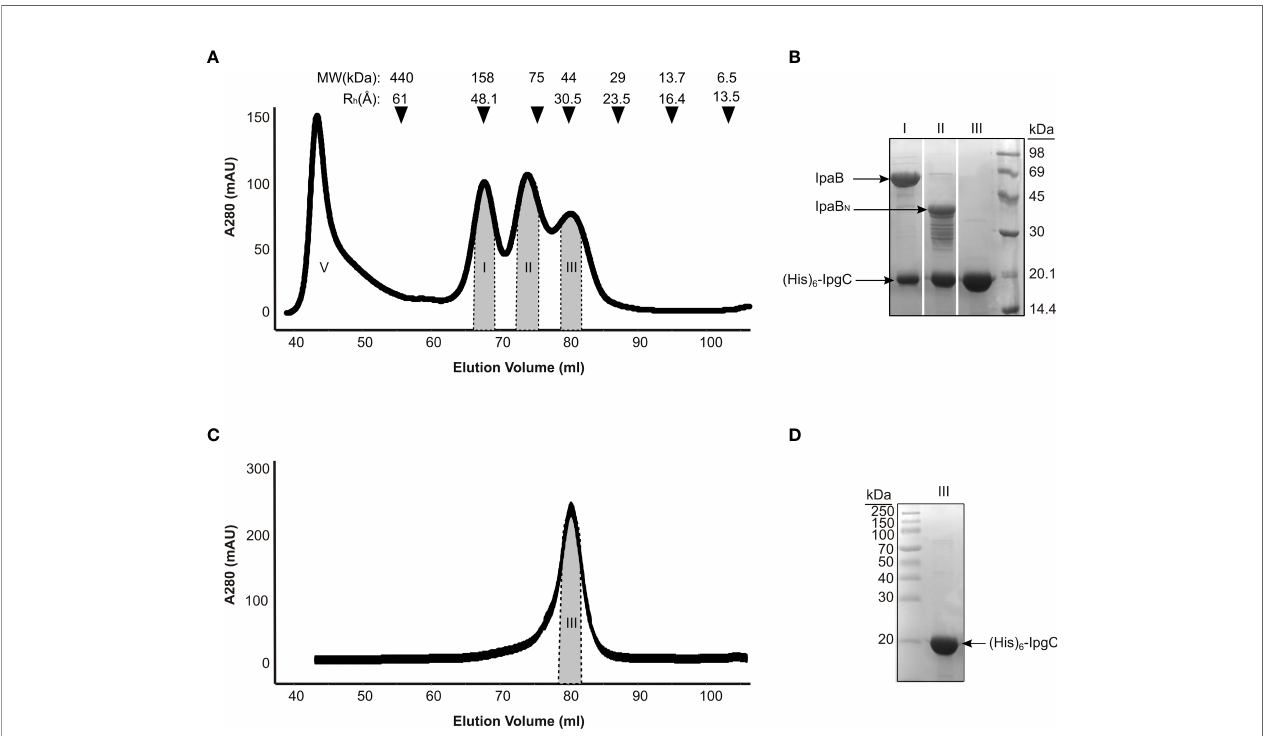
FIGURE 2 | IpgC/IpaB available structural information and hydrodynamic parameters. (A) Chromatograph of Size Exclusion analysis on the elution fractions of the IpgC/IpaB complex collected following the metal af fi nity puri fi cation step. Four peaks are observed; V: Void Volume; I: The IpgC/IpaB peak as judged by the SDS- PAGE analysis in (B) ; II: A proteolytic form of IpaB in complex with IpgC; and III: IpgC alone. On top of the graph the apparent Molecular Weights (MW) and the Hydrodynamic Radii (R h ) of the molecular markers used to calibrate the size exclusion chromatography column are shown. (B) SDS-PAGE analysis of the various peaks in A after their collection and concentration. (C) Chromatograph of Size Exclusion analysis on the elution fractions of the IpgC collected following the